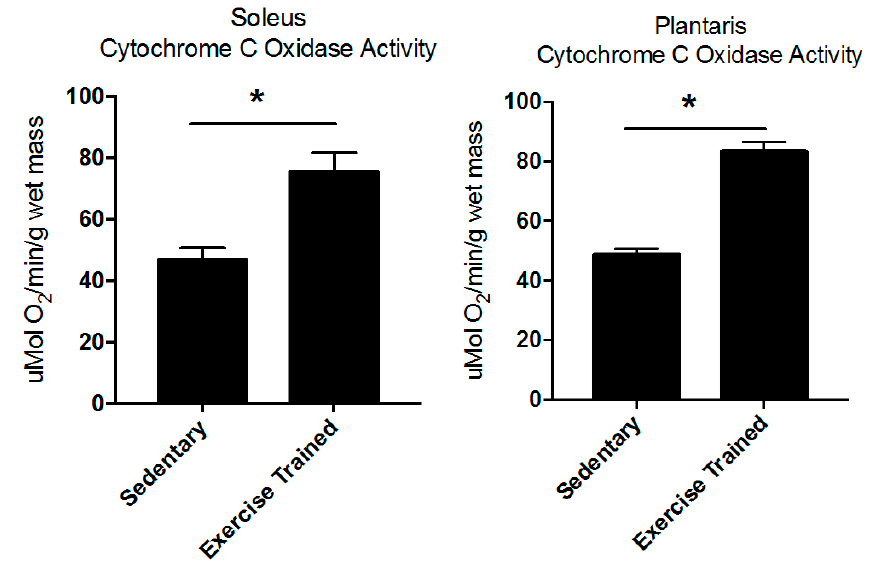
Figure 1. Exercise-induced increases in soleus and plantaris cytochrome c oxidase activity. Total Cytochrome c oxidase activity in sedentary and exercise trained rats ( N = 9–10/group). * P < 0.05 vs. sedentary. Values are expressed as mean values ± SE ( N = 9–10 muscles/group).